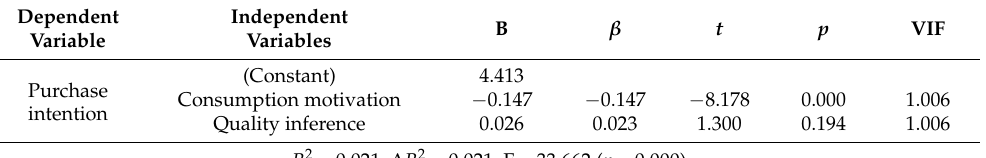
Table 10. Experts: Results of multiple regression analysis to identify factors influencing purchase intention.